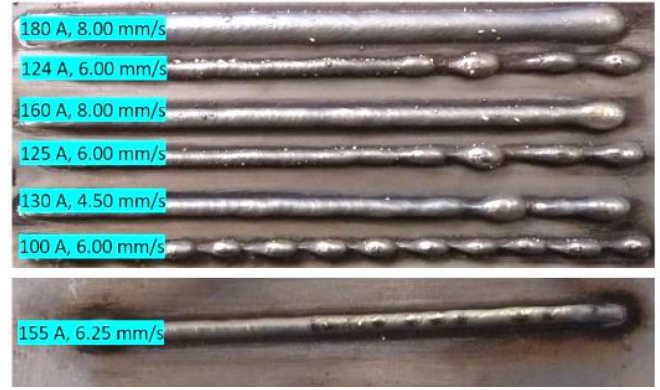
Figure 7. Bead-on-plate depositions (one layer) from the experiments carried out while determining the workable current range.